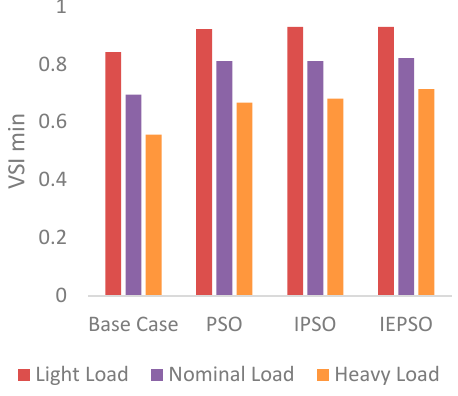
Figure 5. Voltage stability index for different load levels for DNR in 33-bus test system.